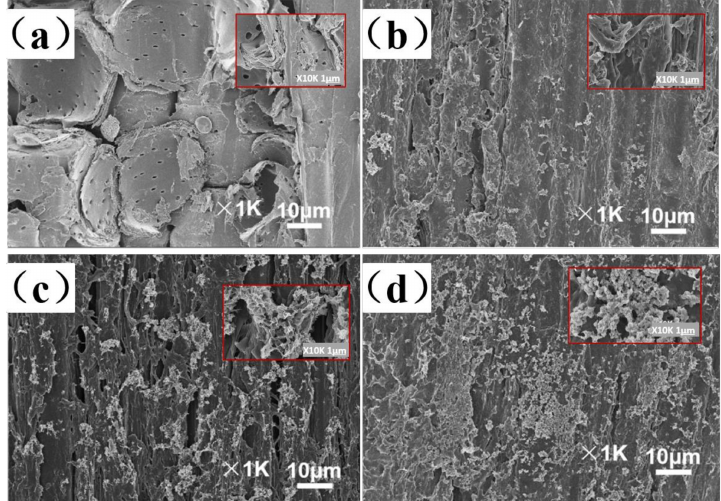
Figure 3. The surface morphology of the bamboo surface before and after treated: ( a ) OB, ( b ) U2-t1, ( c ) U2-t2, ( d )